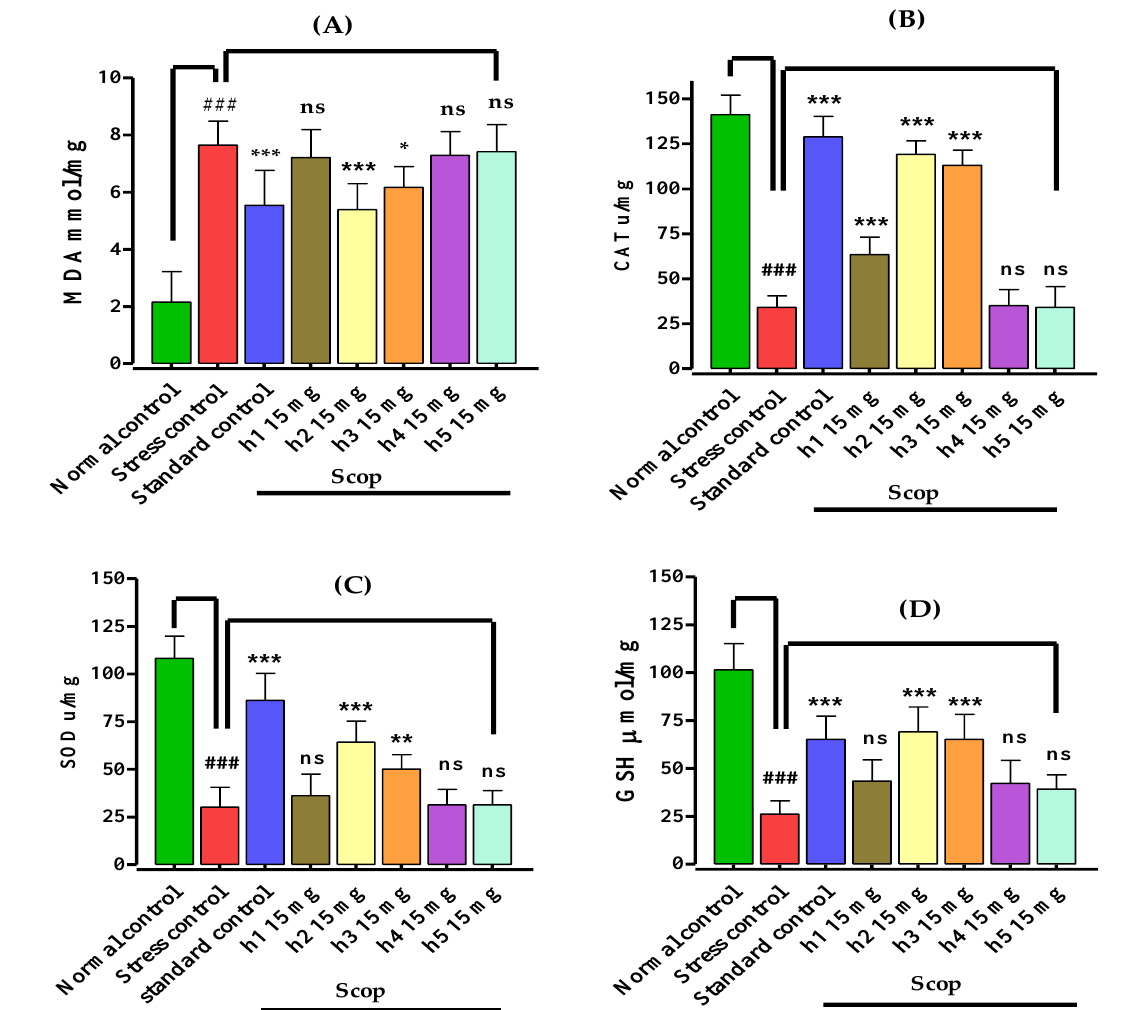
Figure 5. Effect of mono-carbonyl curcumin analogues ( h1 – h5 ) on the ( A ) malondialdehyde (MDA) level, ( B ) catalase (CAT) activity, ( C ) superoxide dismutase (SOD) activity, ( D ) glutathione (GSH) activity in the hippocampus while donepezil served as standard control. Results are shown as mean ± SD, n = 8. Kolmogorov–Smirnov test was applied for normality distribution and each data set was found to have a normal distribution. One-way ANOVA, followed by Bonferroni’s multiple comparison tests (post hoc), was applied on each data set and expressed as ### p < 0.001 vs. normal control group, and *** p < 0.001, ** p < 0.01, * p < 0.05, “ ns ” p ˃ 0.05 vs. stress control group.